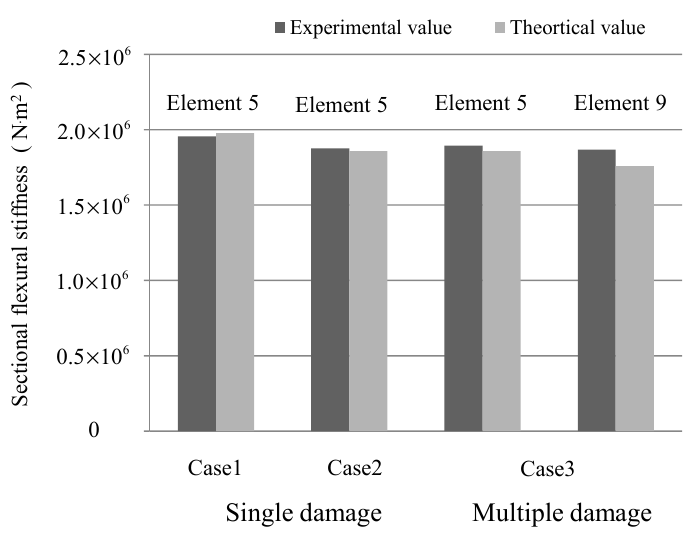
Figure 6. Damage quantification for three cases.